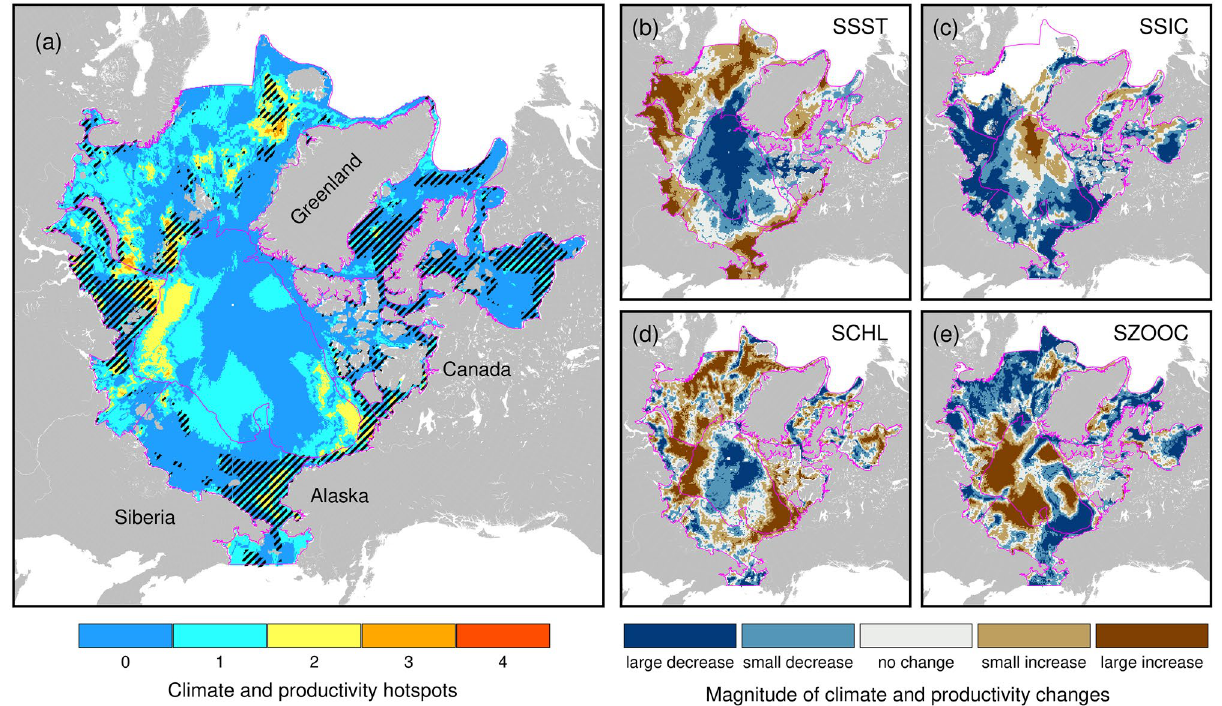
Figure 6. ( a ) Climate and productivity hotspots in Arctic marine areas defined as areas of overlap of two or more large changes in summer ( b ) sea surface temperature (0.21 °C ≤ SSST ≤ 0.76 °C), ( c ) sea ice concentration (− 2% ≥ SSIC ≥ − 76%), ( d ) chlorophyll-a concentration (0.26 mg·m −3 ≤ SCHL ≤ 0.73 mg·m −3 ), and ( e ) zooplankton biomass (0.21 g·m −2 ≤ SZOOC ≤ 0.75 g·m −2 ). Hatched areas in ( a ) correspond to areas of species accrual (defined as areas with species gains ≥ 1 species/decade) over the entire study period. The maps were created using GMT 6.3.0 (https:// docs. gener ic- mappi ng- tools. org/6. 3/ gmt.